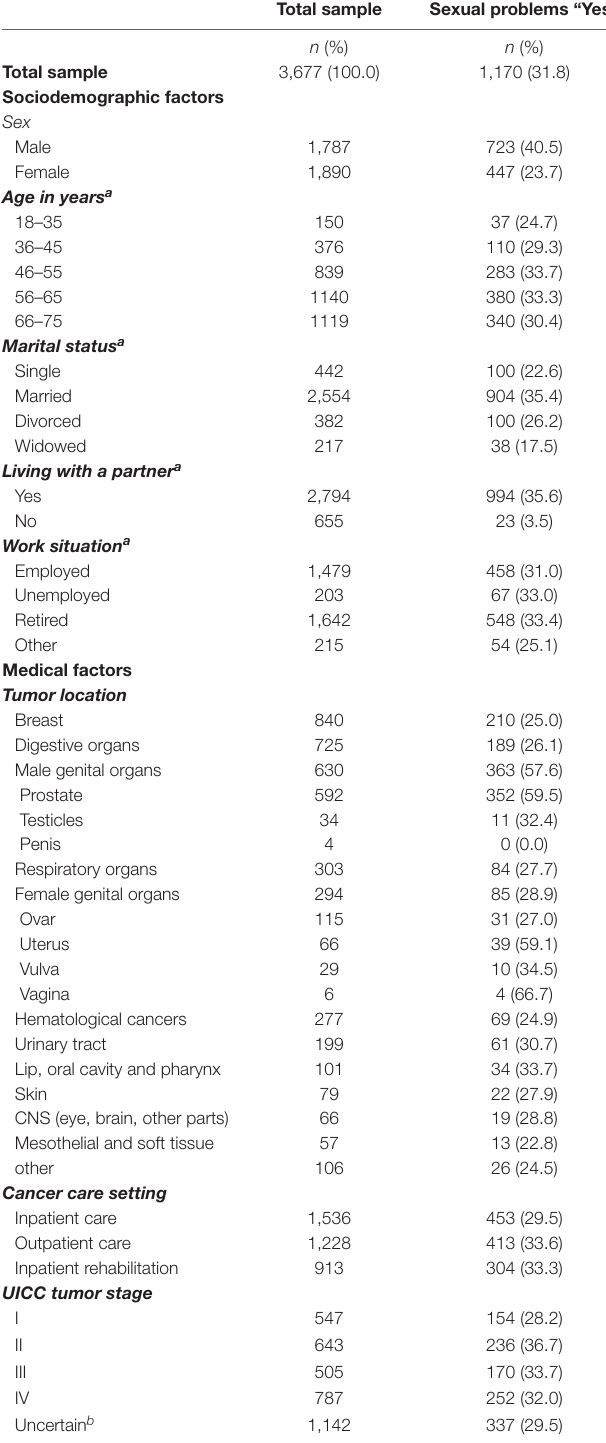
TABLE 1 | Sociodemographic and medical factors of cancer patients stating sexual problems compared with total sample.